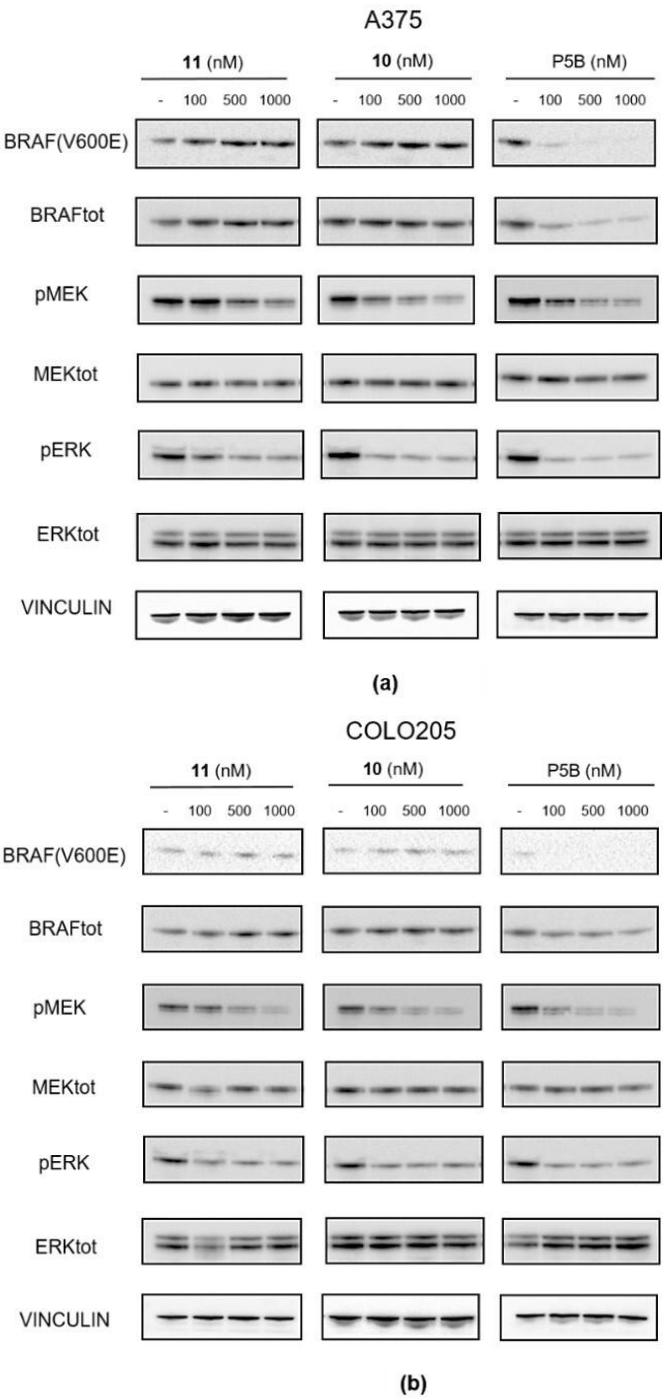
Figure 7. Western blot (WB) analysis of BRAF signaling in ( a ) A375 and ( b ) Colo205 cell lines treated with different concentrations of compounds 10 , 11 and P5B. The reported WB is one representative analysis of three different